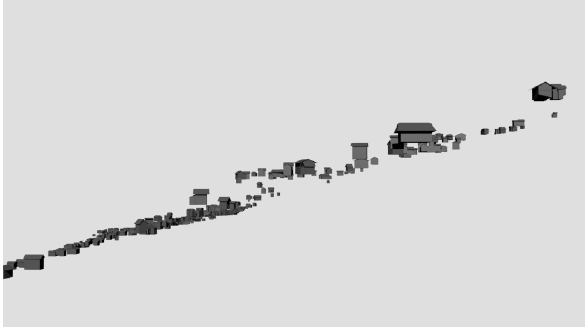
Figure 8: 3D city model with large elevation differences. list. These scores represent a probability for every region that in-